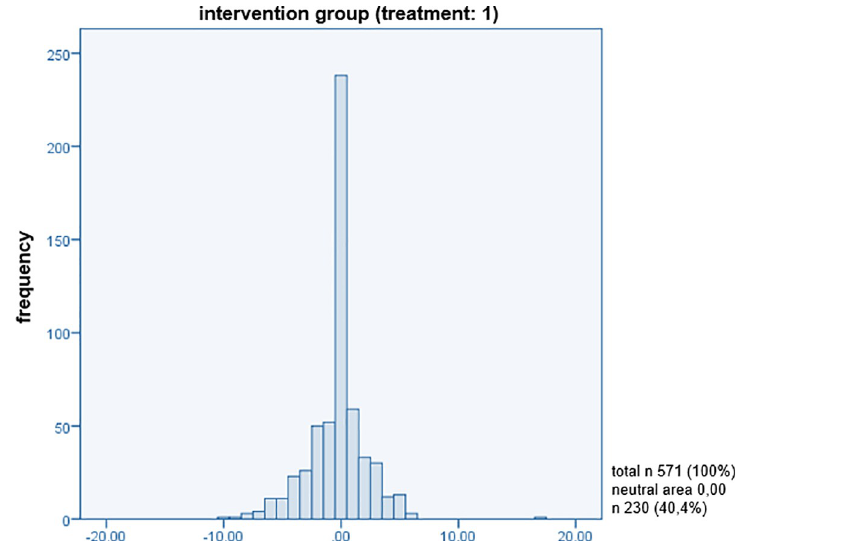
Fig 1. Intervention group (treatment: